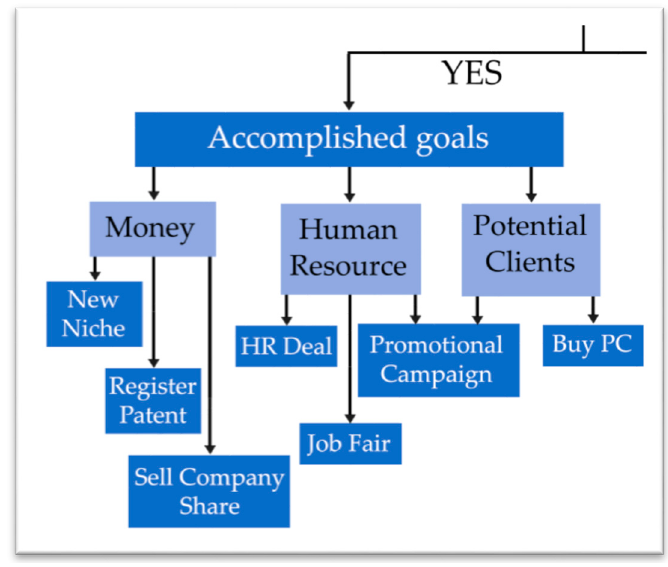
Figure 6. Accomplished goals-decisions